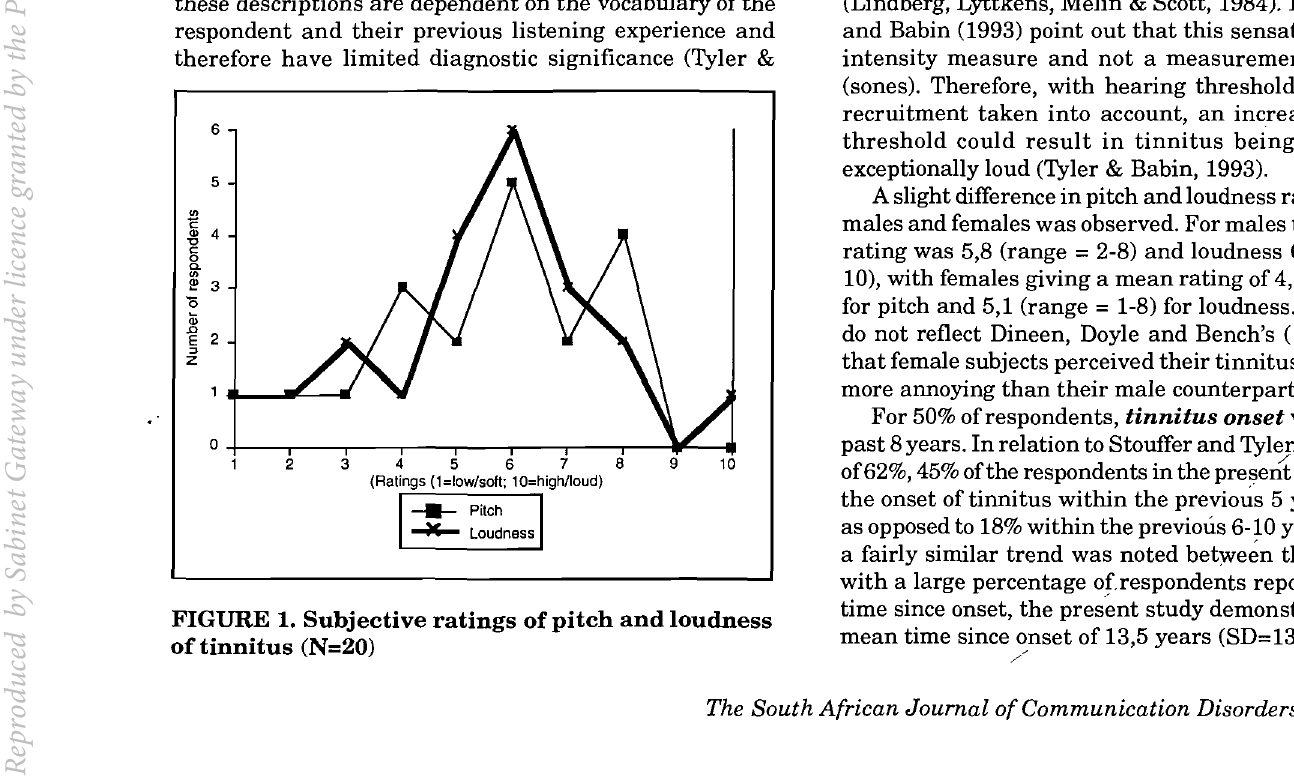
FIGURE 1. Subjective ratings of pitch and loudness of tinnitus